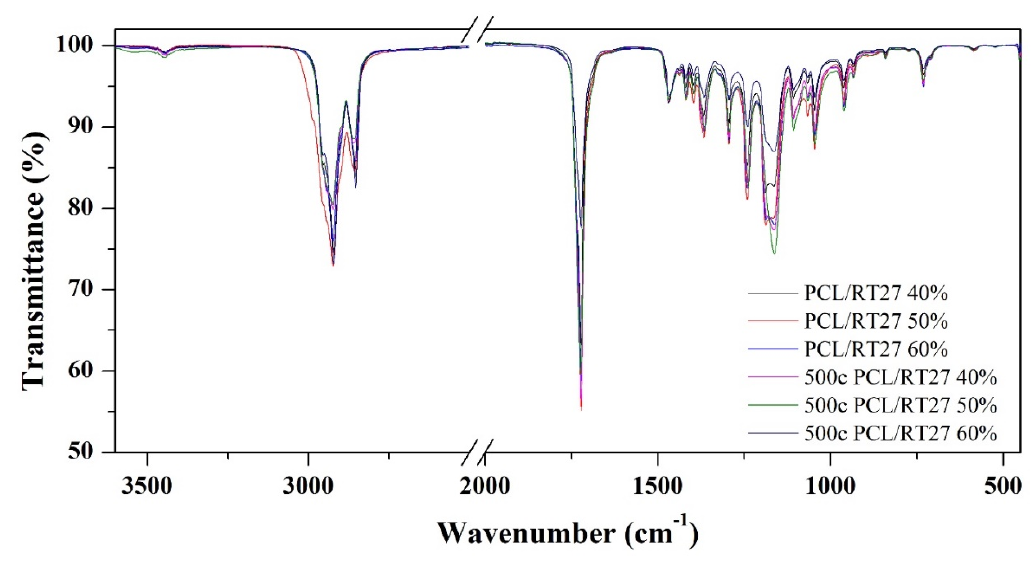
Figure 9. FT-IR spectra before and after the thermal cycling of RT27 CSS-PCM from 40 to 60 wt.%.